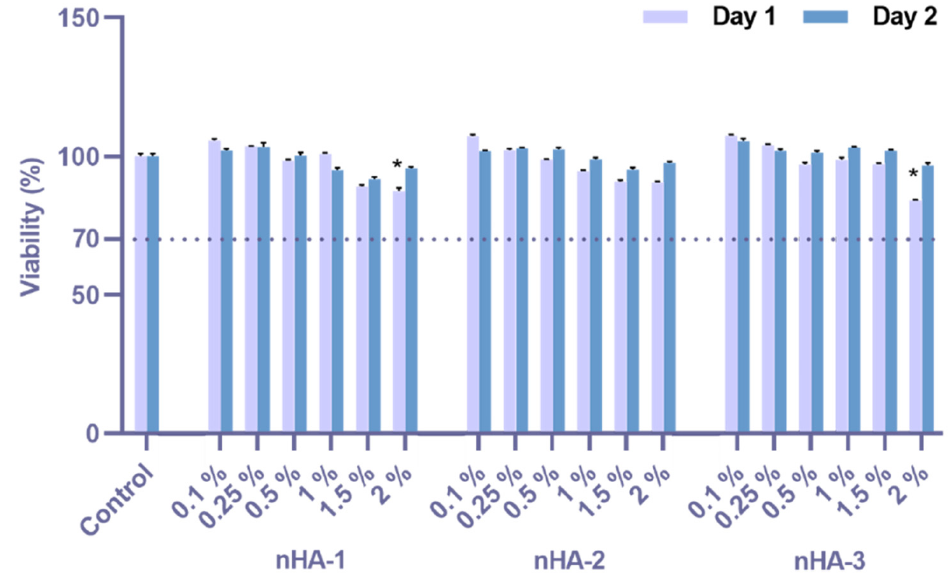
Figure 6. Assessment of cytotoxicity of nHA-1, -2 and -3 samples at the concentrations of 2% (corresponds to 3.1 mg/mL), 1.5%, 1%, 0.5%, 0.25%, and 0.1% v / v according to ISO 10993-5 (2009) using the resazurin-based cell viability reagent PrestoBlue ® . Cell viability of L-929 fibroblasts was expressed as % of the control (control was set at 100%). The values represent means ± standard deviation of quadruples of three independent experiments (n = 12), and the asterisk (*) designates significant differences compared to the TCPS control ( p =